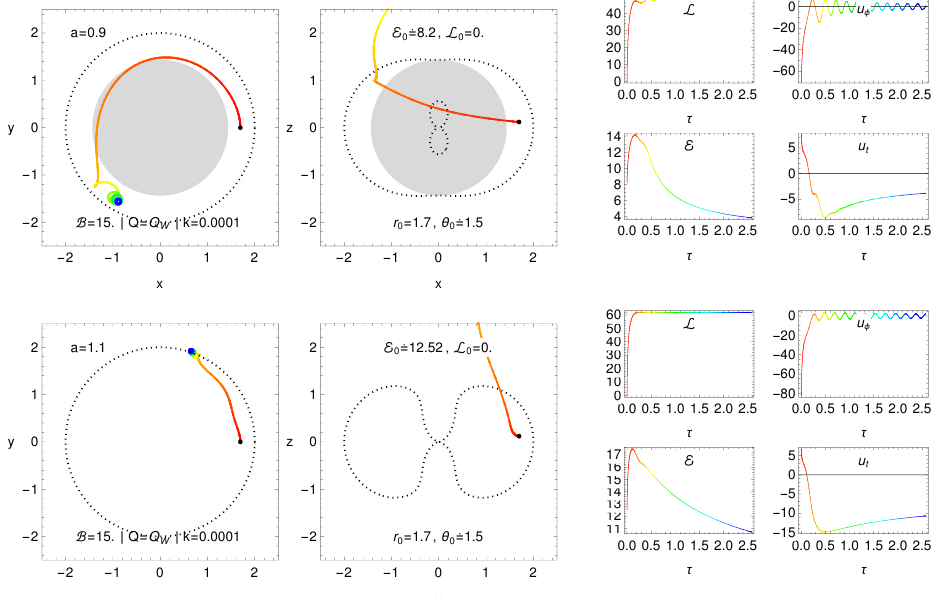
Figure 10. Charged particle escape after gaining energy due to the RPP. We compared the character of the orbits in the black hole and naked singularity spacetimes.